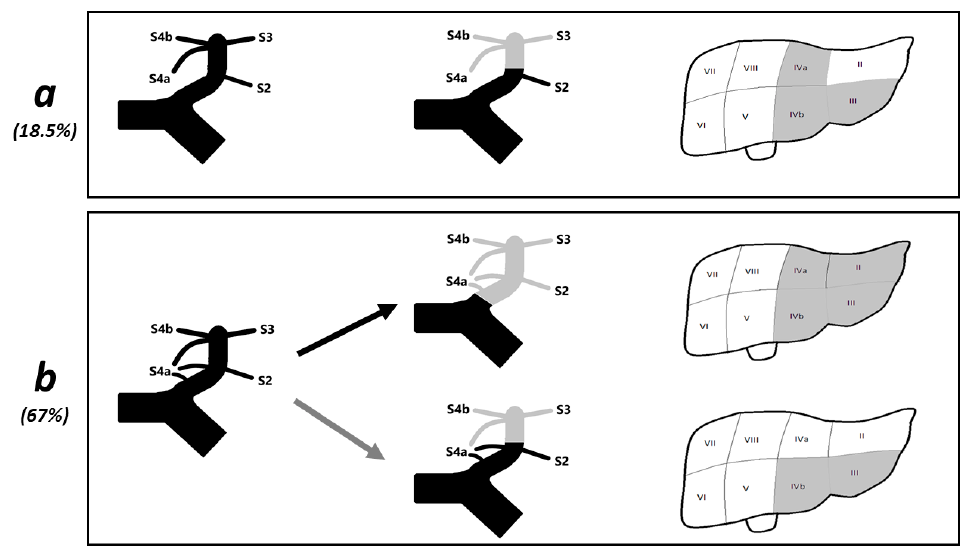
Figure 4. Implications of the left portal branching on the sub-division in anatomo-functional unites of the left liver. A schematic illustration of the left medial sector (LMS). The systematization of the left liver in sectors following the Brisbane Classification was applied in two different patterns of branching of the LPV (pictures on the left), with particular attention to the identification of the sectorial portal pedicle supplying the LMS (colored in grey in the picture in the middle) and the portion of parenchima corresponding to the LMS (colored in grey in the picture on the right). ( a ) This picture shows a pattern of left portal branching in which both S4a and S4b are exclusively supplied by multiple portal branches originating from the right horn; no independent portal pedicles for S4a are present (picture on the left). The sectorial portal pedicle (picture in the middle) and the portion of parenchima (picture on the right) corresponding to LMS are represented in grey. In this this type of branching of the LPV, the UPLPV (downstream from the origin of the portal pedicle supplying S2) clearly represents the sectorial portal pedicle for the LMS. This type of branching of the LPV corresponds to pattern III and is present only in 18.5% of patients [7]. ( b ) This picture shows a pattern of left portal branching in which S4a and S4b are supplied by a common portal pedicle originating from the right horn; additionally, S4a is supplied by two independent portal pedicles originating from the angle of the LPV and the TPLPV (picture on the left). This type of branching of the LPV corresponds to a subset of pattern I and is present in 67% of patients [7]. In this this type of branching of the LPV, the sectorial portal pedicle of the LMS can be identified following different criteria: Black arrow: considering that the entire S4 should be considered part of the LMS, the origin of the sectorial portal pedicle for the LMS should be identified upstream from all portal pedicle supplying S4. As a consequence, the segmental portal pedicle for S2 would be included in the sectorial portal pedicle for the LMS, and the LMS would correspond to the left liver. Grey arrow: considering that S2 should be excluded from the LMS, the origin of the sectorial portal pedicle for the LMS should be identified downstream from the origin of the portal pedicle for S2. As a consequence, the independent proximal portal pedicles for S4a would be excluded by the sectorial portal pedicle for the LMS, and the LMS would correspond to the LAS. (S2, segment 2; S3, segment 3; S4a, segment 4 superior; S4b, segment 4 inferior).